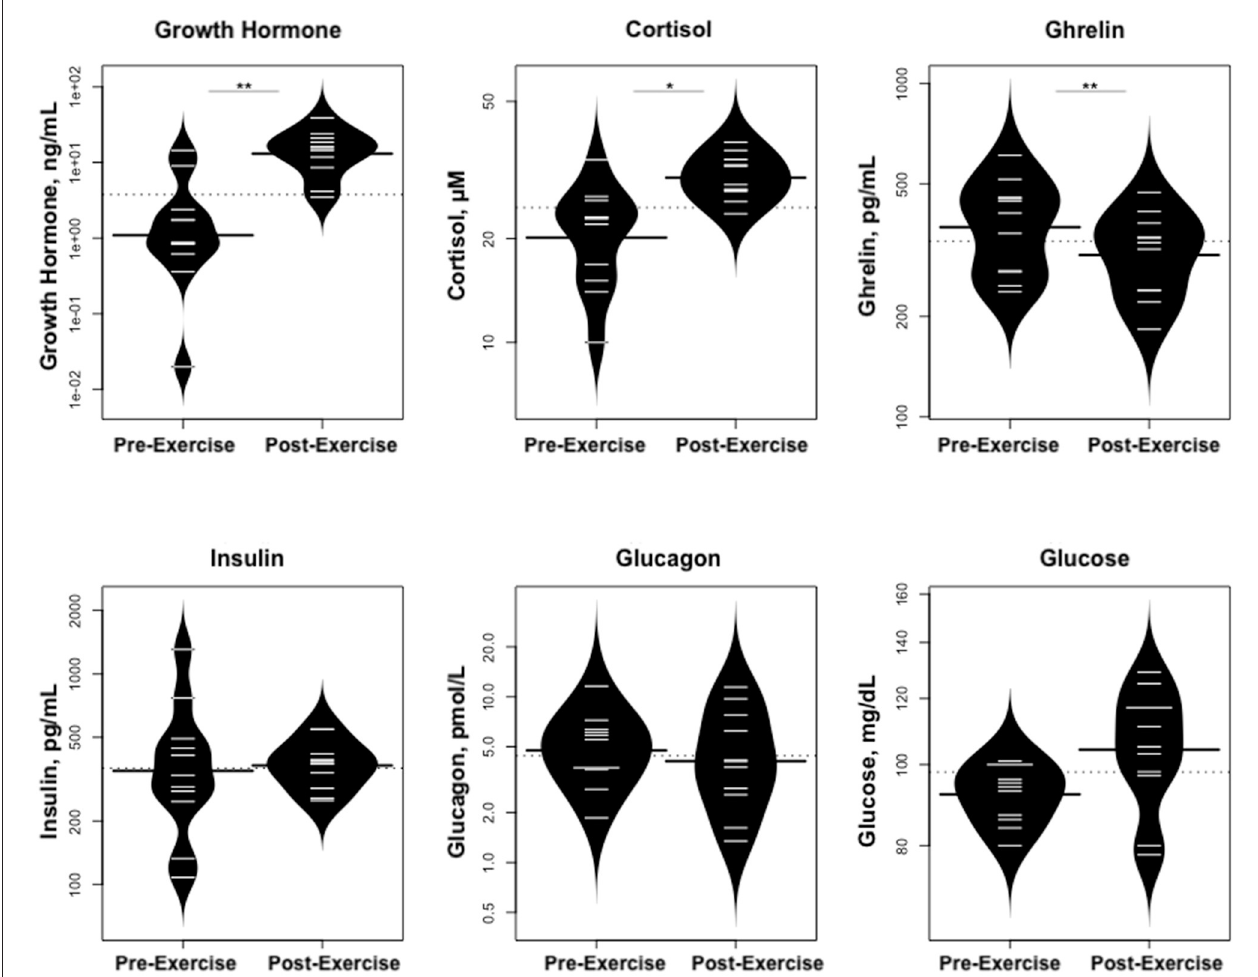
FIGURE 5 | Changes in hormones controlling changes in metabolites and changes in glucose concentrations. * p < 0.01, ** p < 0.001.